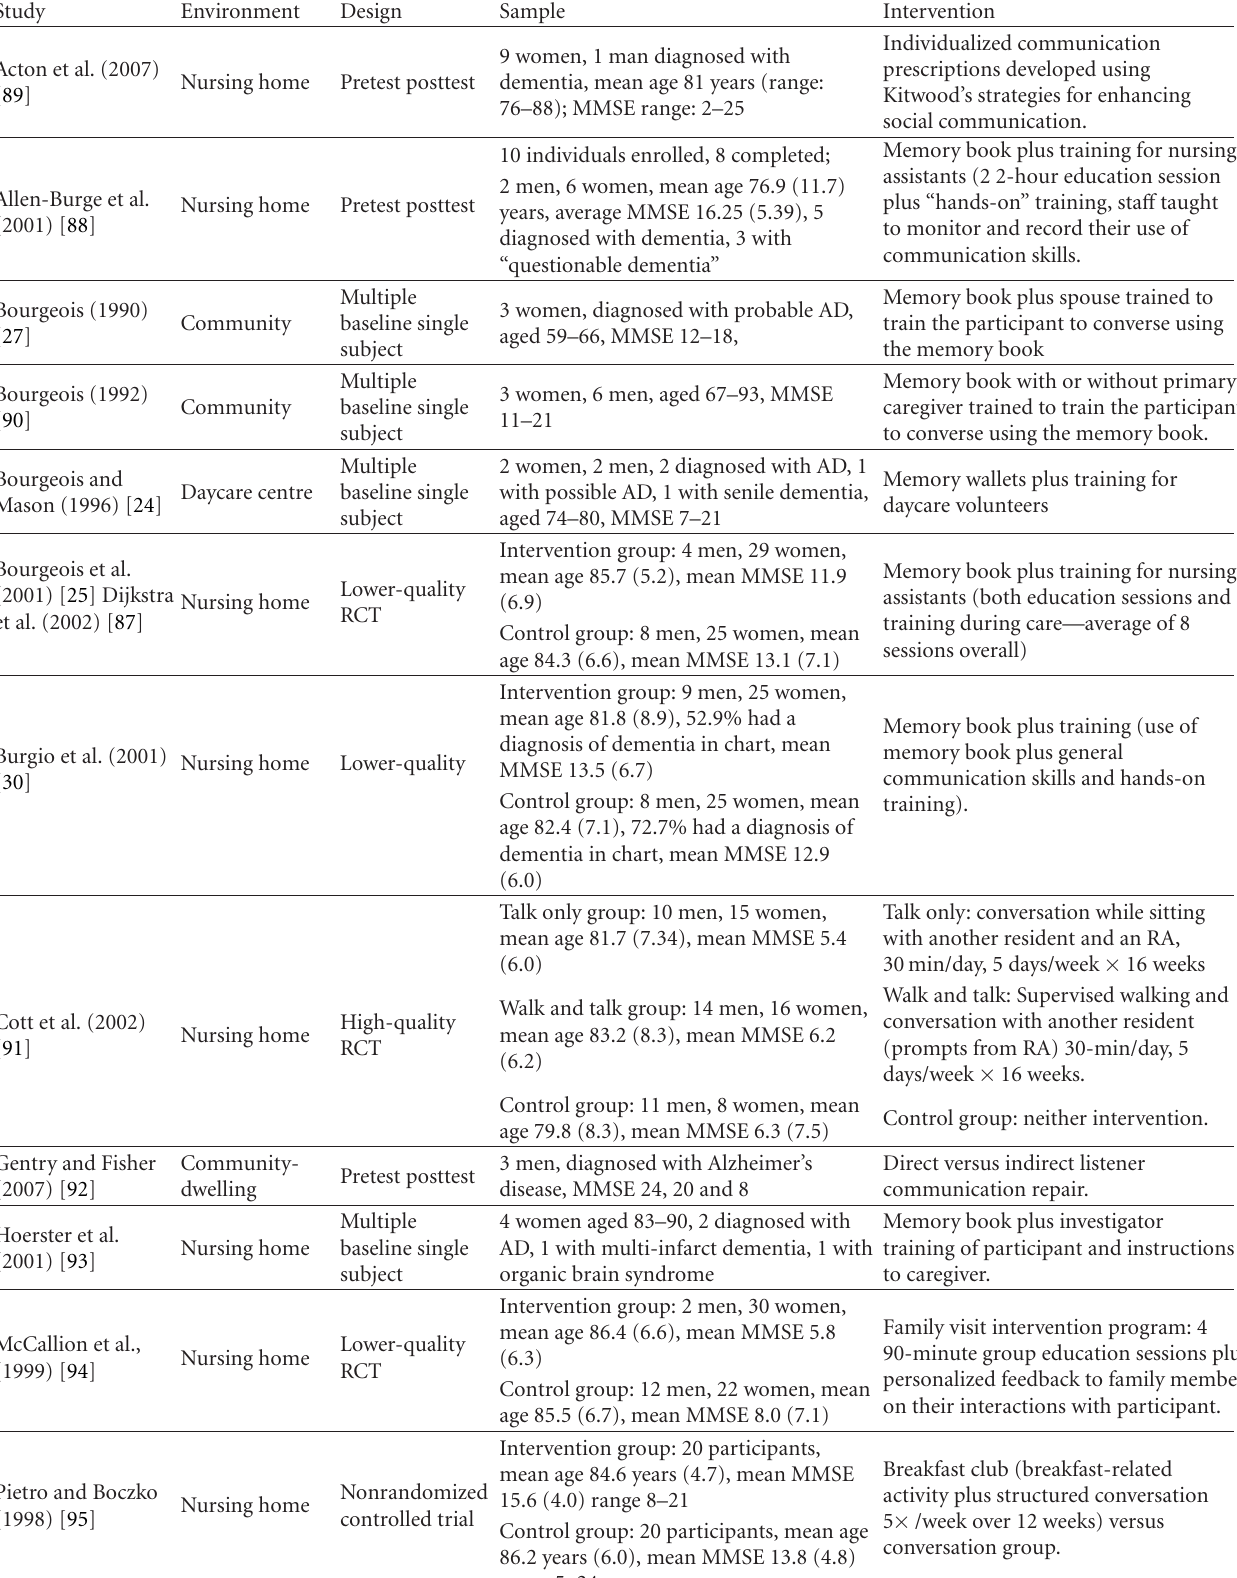
Table 2: Included